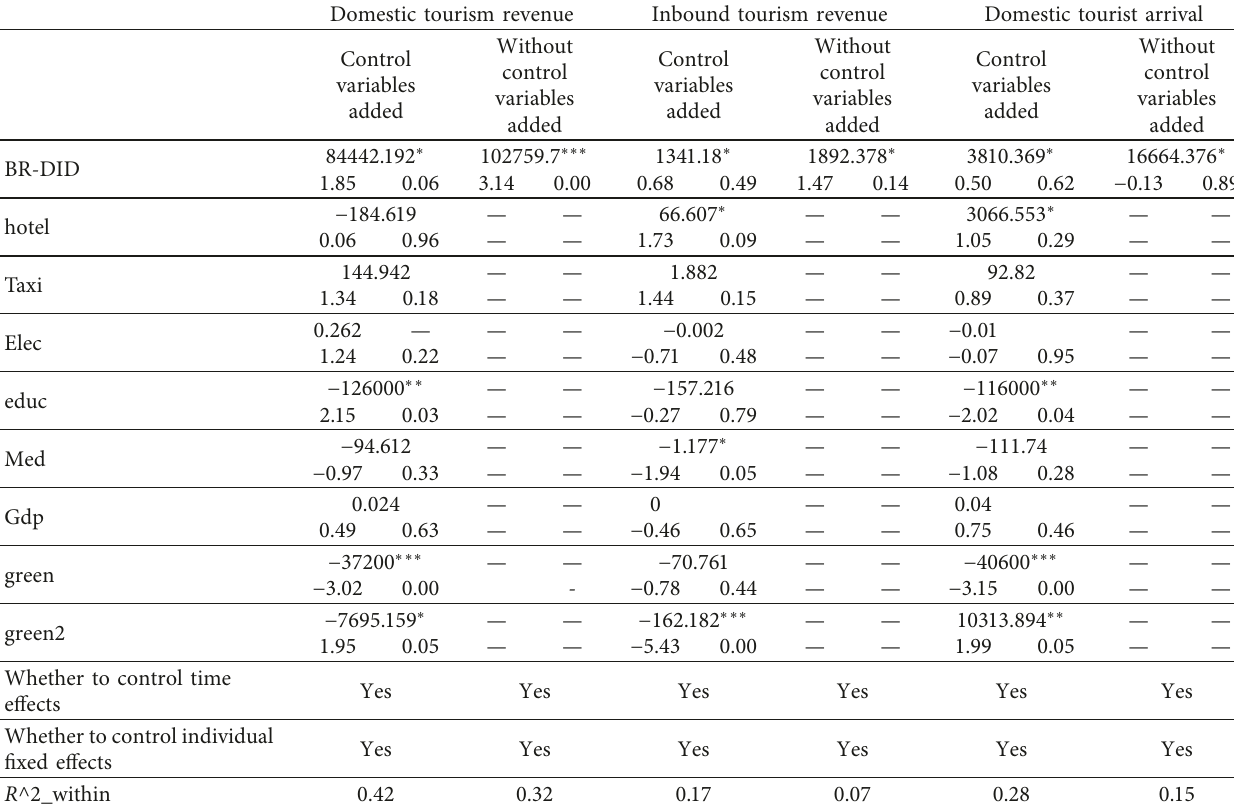
Table 2: Impact of “one belt, one road” on the tourism economy of the regions along the route (a).